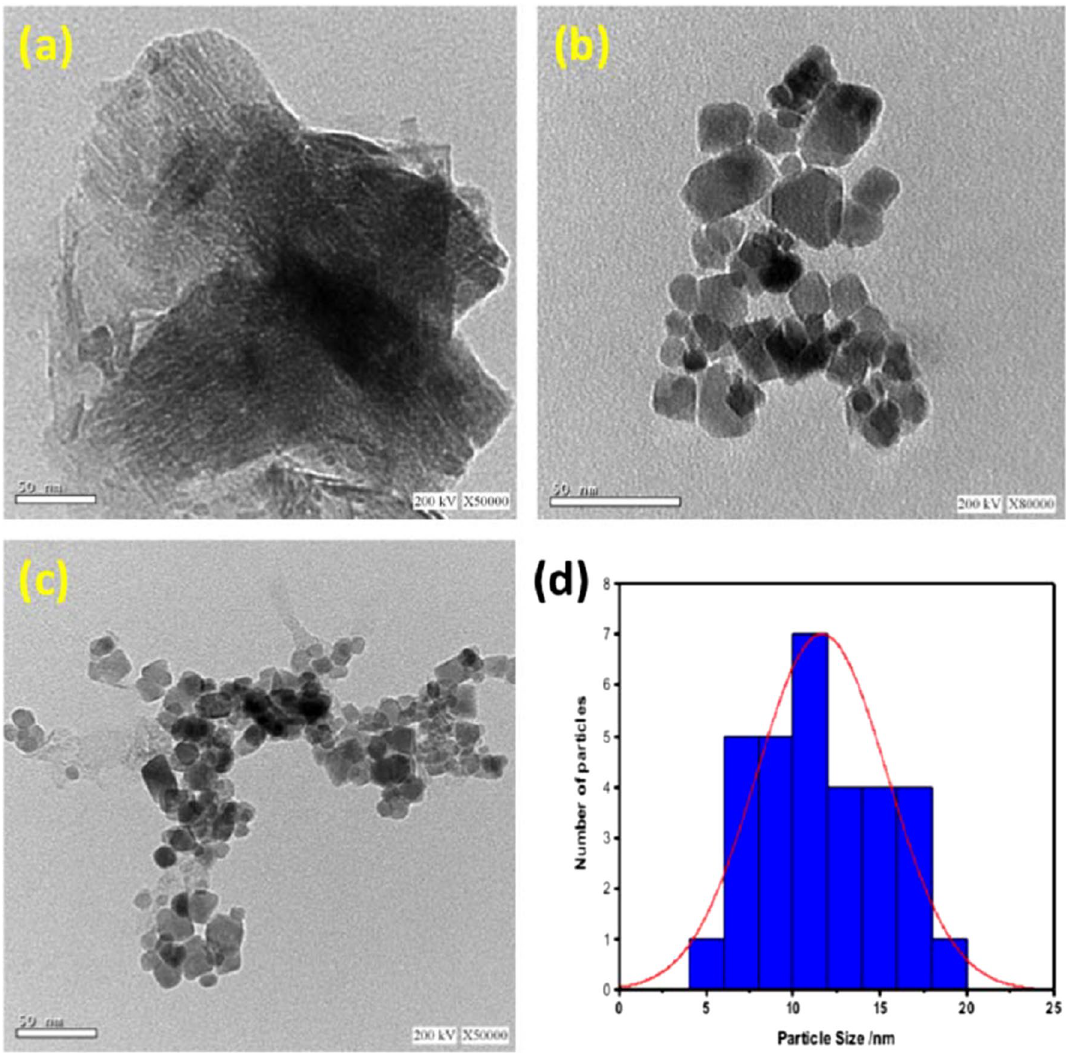
Fig. 3 TEM images of a SWD, b Fe 3 O 4 nanoparticles and c SWD@Fe 3 O 4 nanoparticles